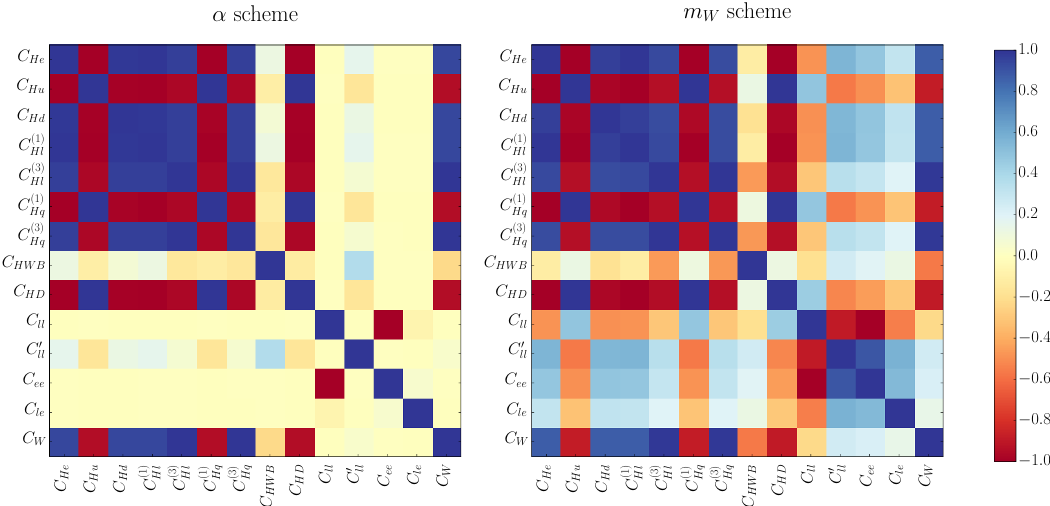
Figure 5 . Color map of the correlation matrix among the Wilson coe(cid:14)cients, obtained assuming zero SMEFT error, for the scheme (right).